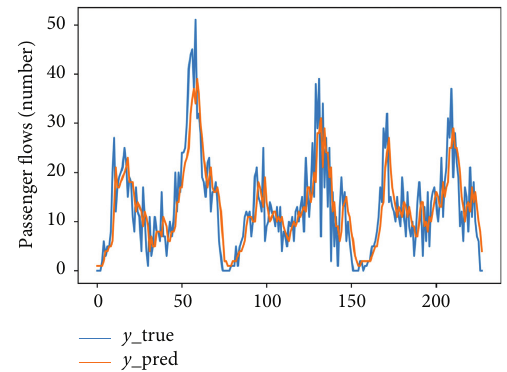
Figure 10: Regression integration prediction results when the time step is 2 h.